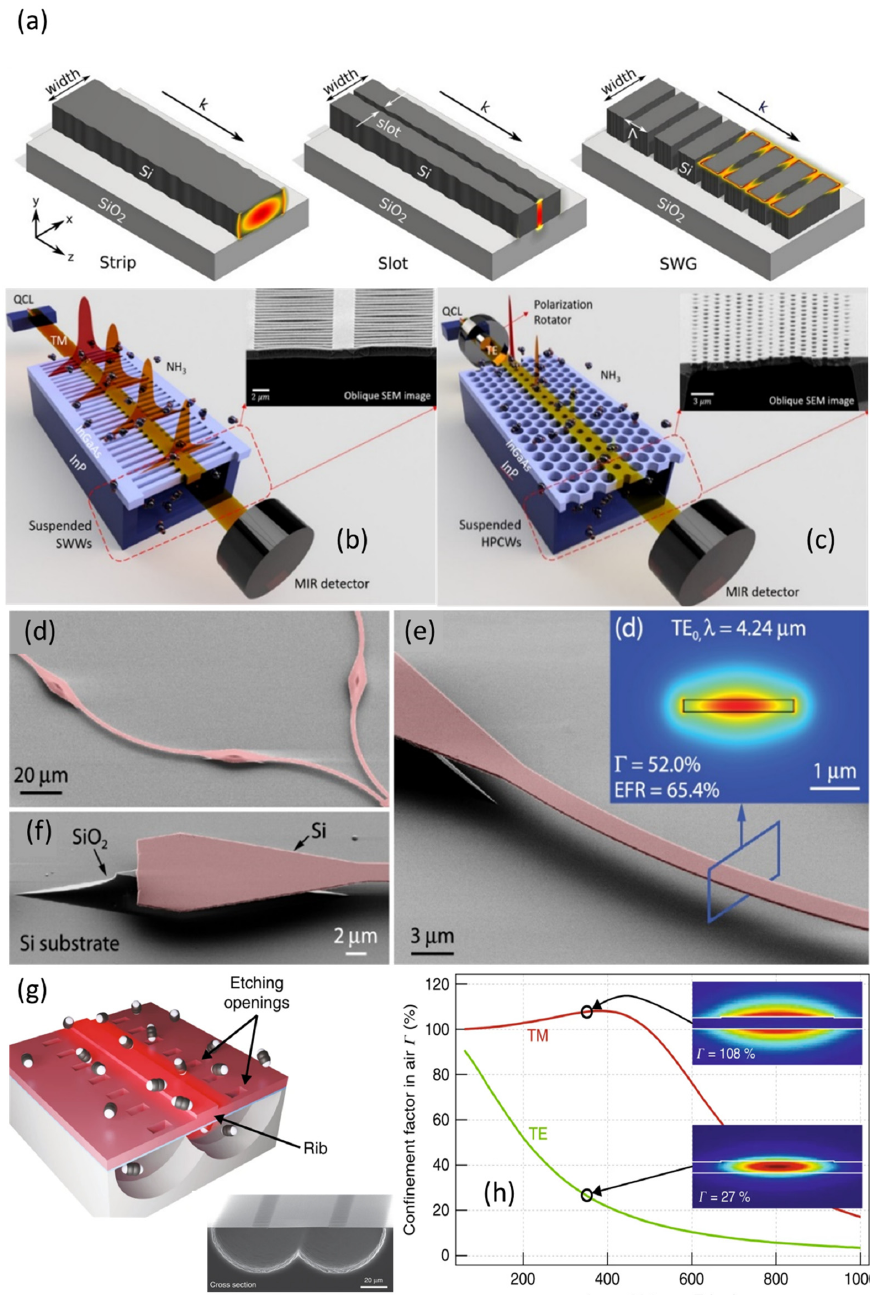
Figure 1. Different waveguide designs reported for WIRAS: ( a ) Strip, slot and subwavelength grating waveguides (SWG) (reproduced with permission from reference [70] © 2021 Optical Society of America). ( b ) Suspended subwavelength grating waveguide and ( c ) suspended photonic crystal waveguide. The insets show SEM images of the fabricated structures (reprinted with permission from reference [63], copyright 2020 American Chemical Society). ( d – f ) Suspended waveguides on pedestals; the inset in image ( e ) shows the cross-section and the electrical field distribution (reproduced with permission from reference [73], (© 2021 Optical Society of America). ( g ) Schematic and SEM image of a self-standing rib waveguide. ( h ) Simulated confinement factor of the waveguide in ( g ) at TM and TE polarizations, as a function of layer thickness, while the inset shows the electric field distribution at a thickness of 350 nm. Reproduced from reference [69], licensed under